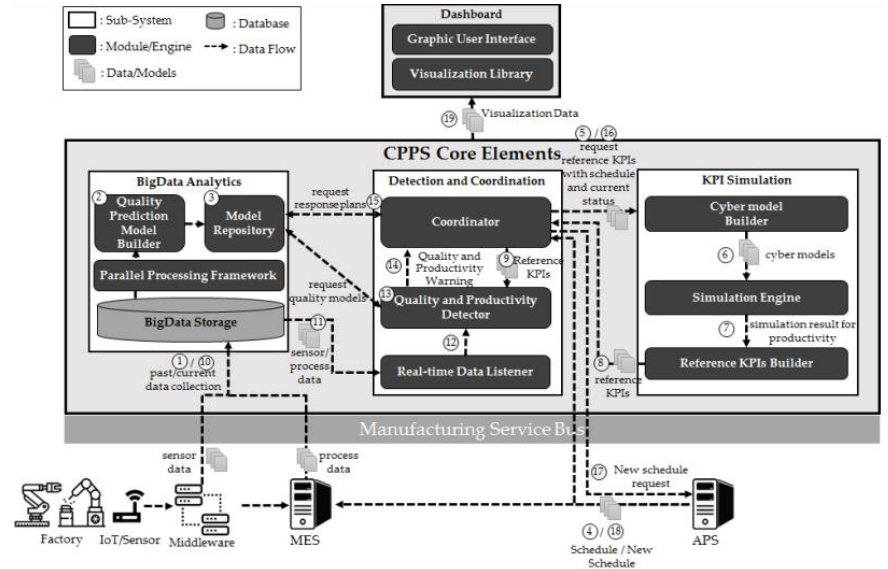
Figure 10. CPPS architecture [85].